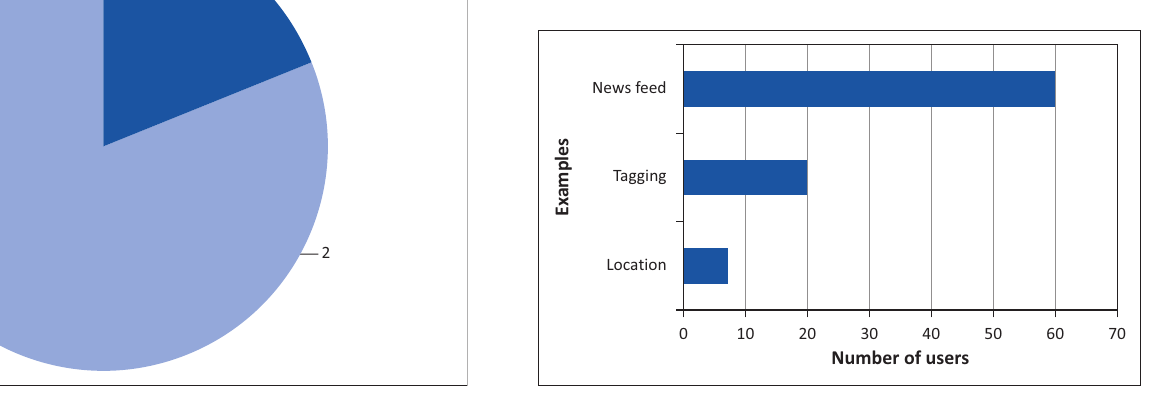
FIGURE 7: Examples of violations of user privacy.